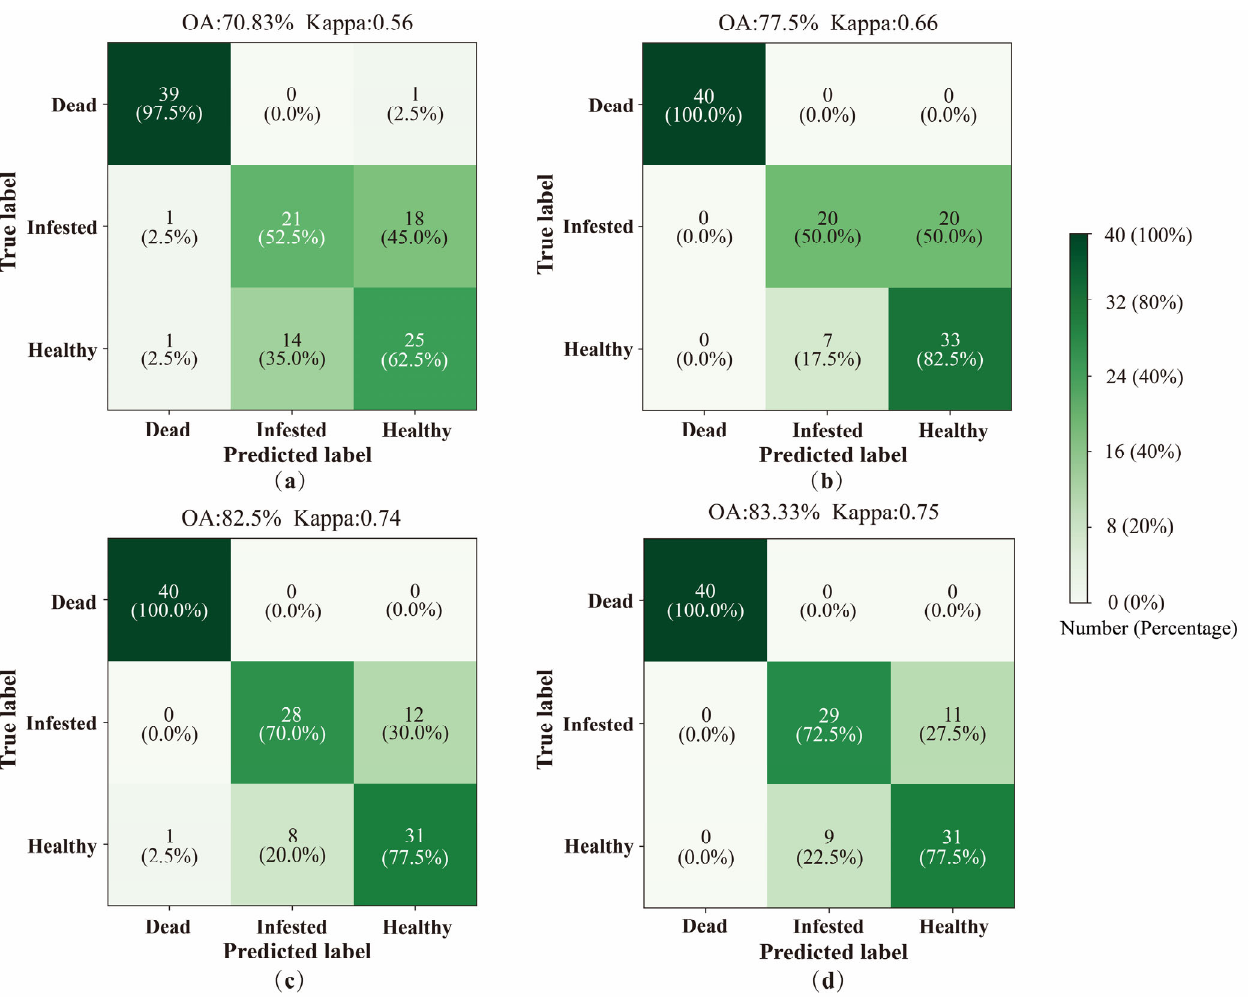
Figure 9. General performance and confusion matrices of the RF and CNN classification models. ( a